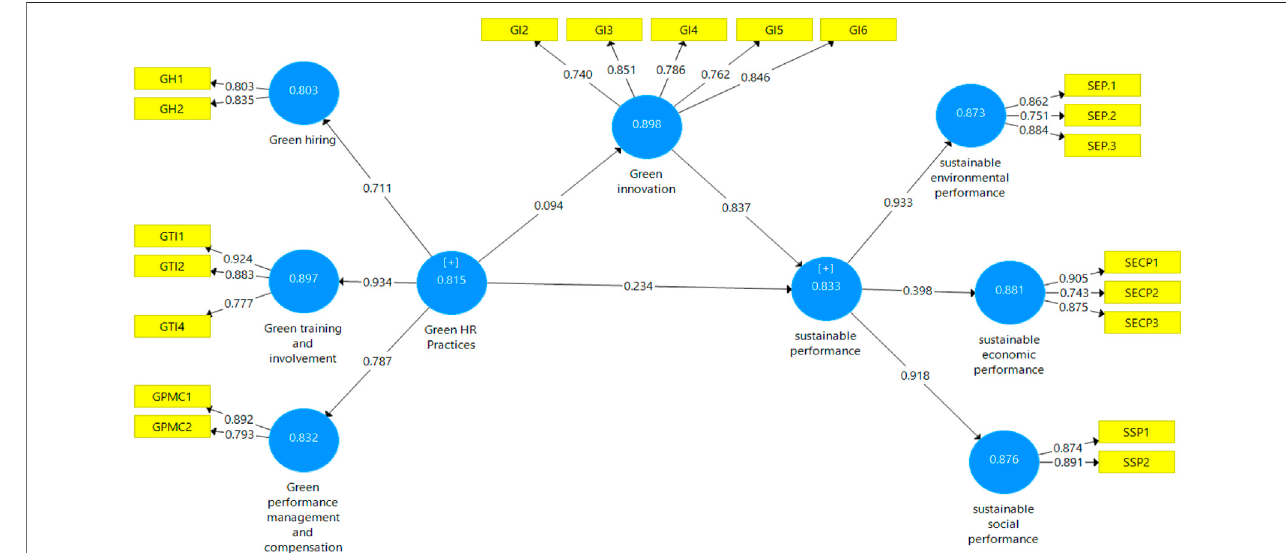
FIGURE 3 | Composite reliability.